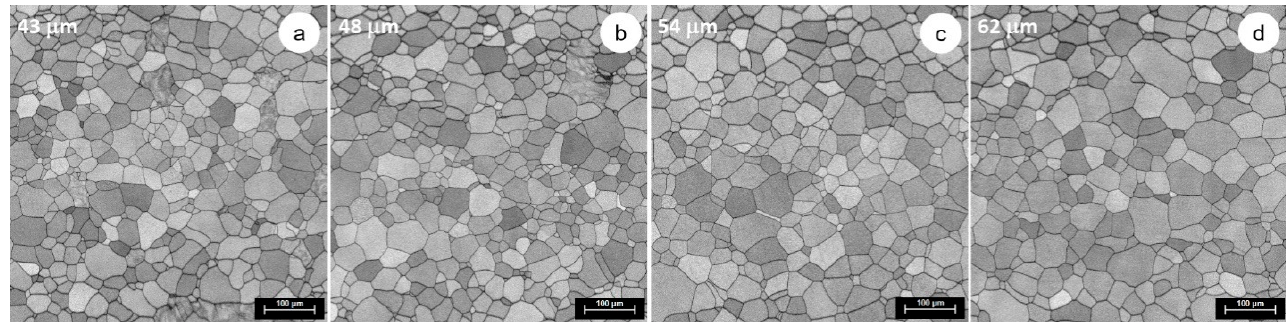
Figure 7. Evolution of the TNTZ alloy microstructure during ST treatment performed at 800 °C for: 5 min (ST 1.1)—( a ); 10 min (ST 1.2)—( b ); 15 min (ST 1.3)—( c ); 20 min (ST 1.4)—( d ).